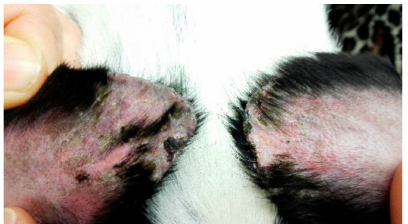
Figure 2. Pinnal vasculitis in a dog, before (on the left) and after treatment (on the right) Courtesy Dr. L. Cornegliani Clinica Veterinaria Citt à di Torino, c.so Traiano 99/d, 1-10135 Torino, Italy [11].